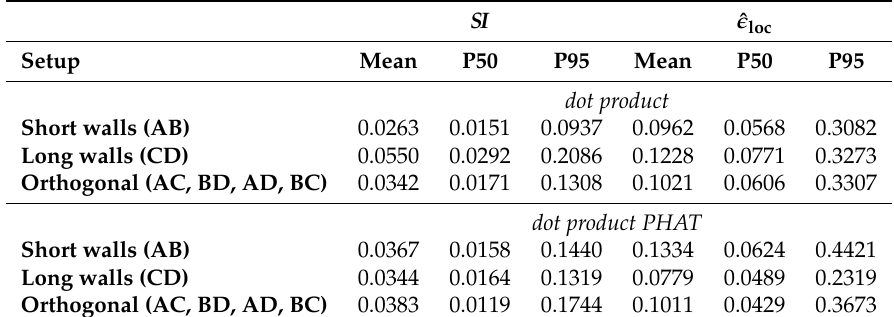
Table 4. SI and ˆ (cid:101) loc assessment of the different array pairs for the two calculation methods using WN